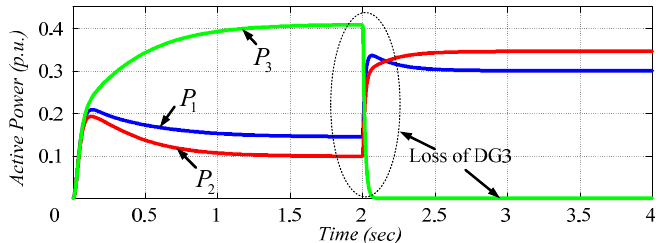
Figure 12. Variations of active power with losing DG3.